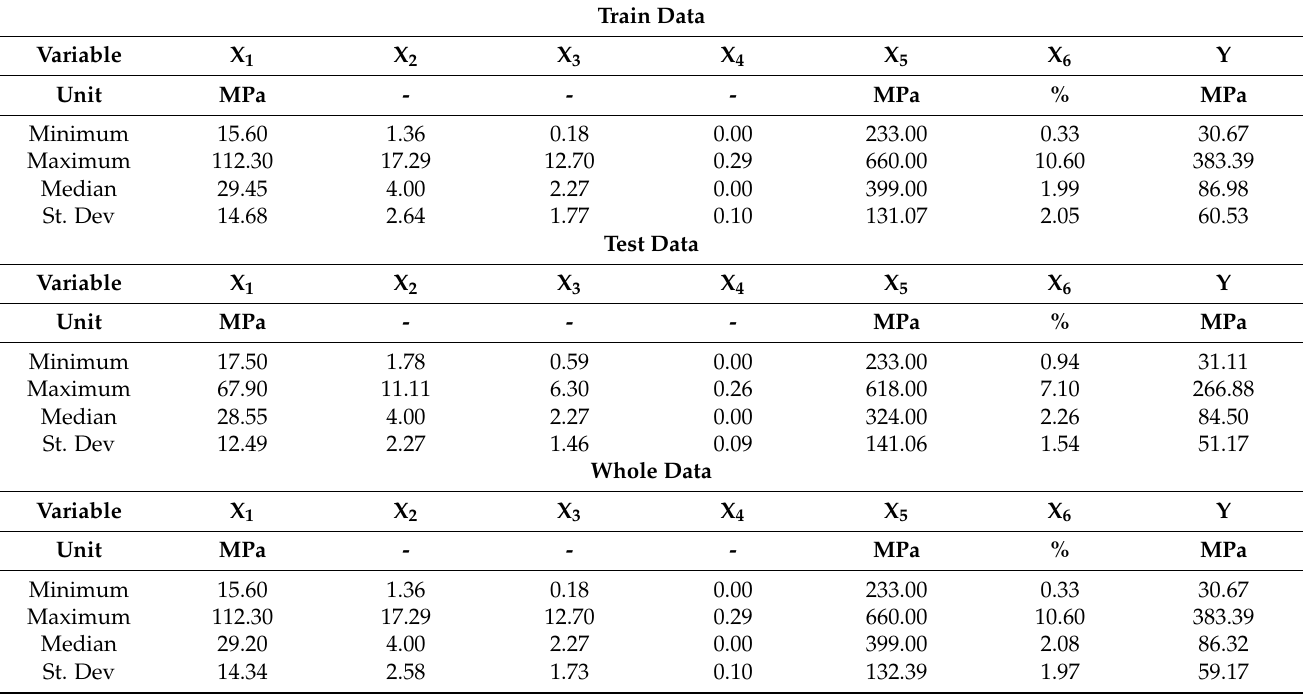
Table 2. Statistical information of the considered database.